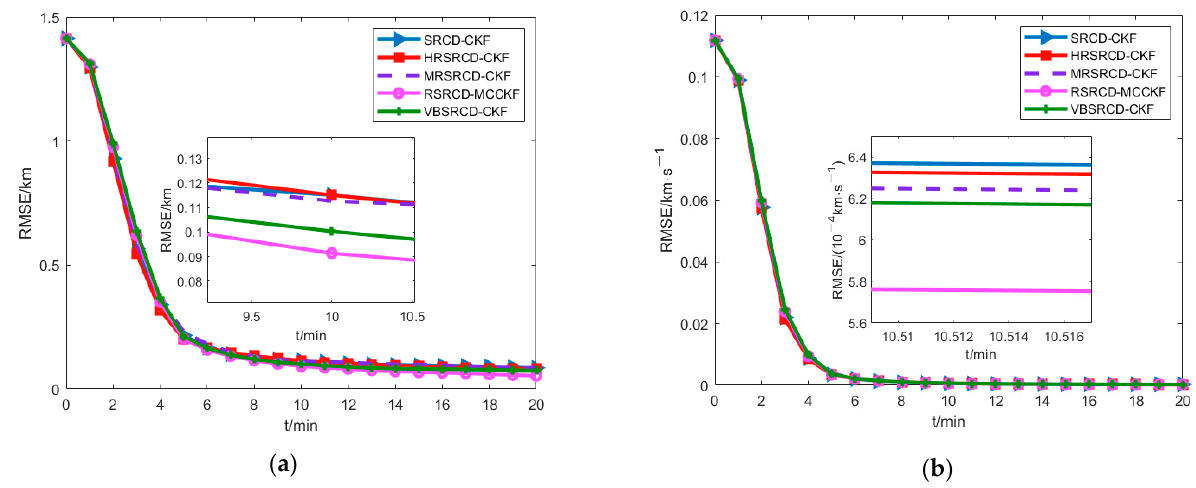
Figure 2. The RMSE comparison of each algorithm under Gaussian noise. ( a ) RMSE pos of each algorithm under Gaussian noise; ( b ) RMSE vel of each algorithm under Gaussian noise.